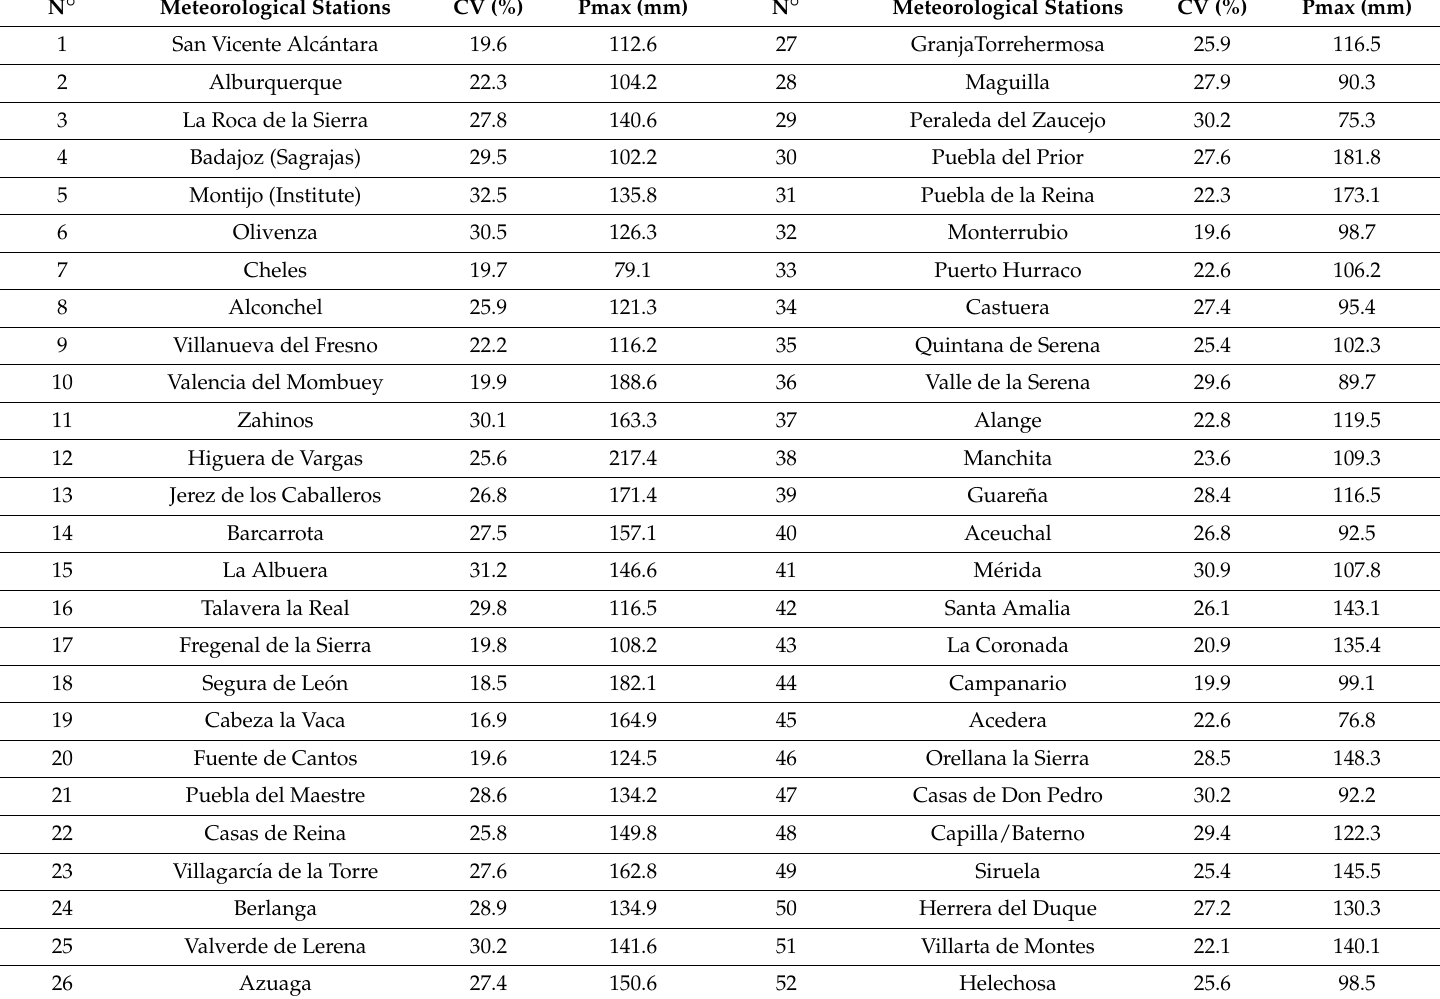
Table 1. Meteorological stations used in the